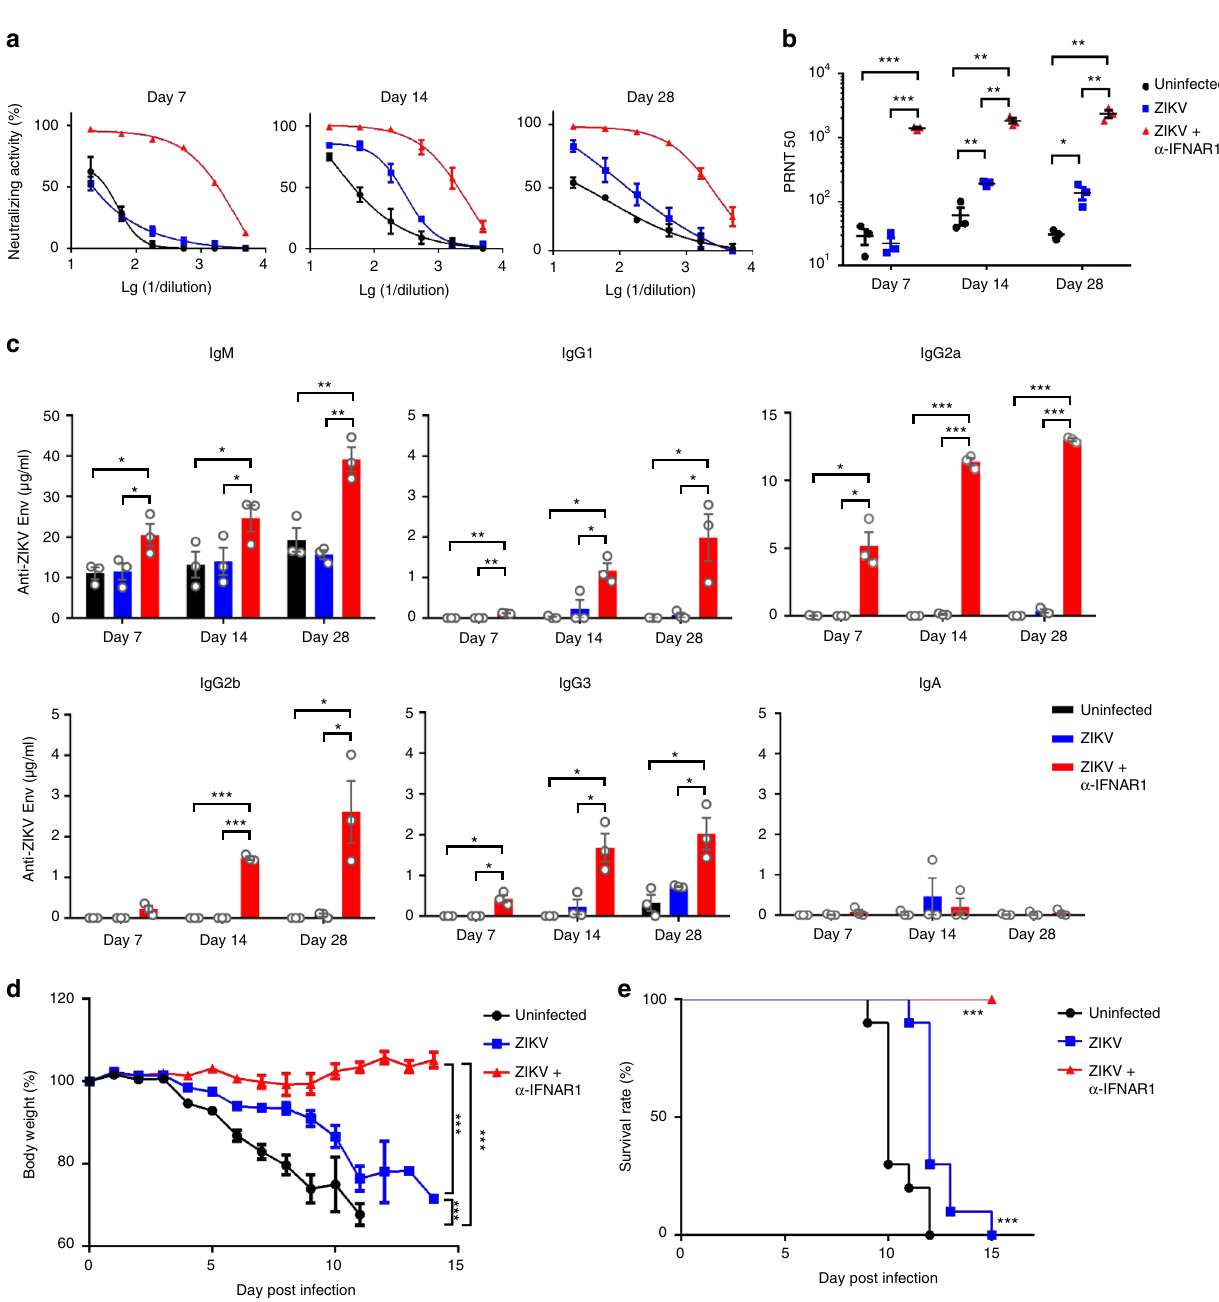
Fig. 1 Immuno-modulation with anti-IFN α / β receptor antibody promotes the induction of protective neutralizing antibody responses after ZIKV infection in immunocompetent mice. a – c Three BALB/c mice per group were administered with PBS control (Uninfected), ZIKV only (ZIKV), or ZIKV + anti-IFN α / β receptor antibody (ZIKV + α -IFNAR1) ( n = 3 for each group). a The kinetics of sera neutralizing antibody responses were examined on days 7, 14, and 28 post infection (dpi). b The PRNT 50 values in each group of mice were measured at the same time points; c The titers of ZIKV envelope protein speci fi c IgM, IgG1, IgG2a, IgG2b, IgG3, and IgA antibodies in sera from each group of mice were measured by ELISA. d , e AG6 mice were adoptively transferred with 14 dpi sera (200 μ l) from PBS, ZIKV, or ZIKV + α -IFNAR1 groups ( n = 10 for each group) one day before they were challenged experimentally with ZIKV (1 × 10 3 PFU). The percentage of body weight ( d ) and survival rate of each group ( e ) were presented. PRNT 50 values were calculated by PROBIT analysis. The summary data were presented as mean ± standard error of mean (SEM). Statistical differences ( b , c ) were determined by Student ’ s t test; Survival rate and body weight ( d , e ) were analyzed by log-rank test and two-way ANOVA; p values were indicated by * p < 0.05, or ** p < 0.01, or *** p < 0.001. Data shown represent two ( a – e ) independent experiments. Source data are provided as a Source Data fi le difference in total Tfh cells between the two groups (Supplementary infection (Fig. 2a and Supplementary Fig. 2 vs. Supplementary Fig. 4c); moreover, GC B-cell responses were slightly reduced in the Fig. 4c and 4d). These data suggest that the robust Tfh, pre-Tfh, and immune-modulated group (Supplementary Fig. 4d). Overall, the GC B cell responses were resulted from both immune-modulation magnitude of changes in Tfh, pre-Tfh, and GC B cell responses and ZIKV infection, but not caused by treatment with the anti- were much less pronounced in LCMV infection than that in ZIKV IFNAR1 antibody alone. NATURE COMMUNICATIONS| (2019) 10:3859